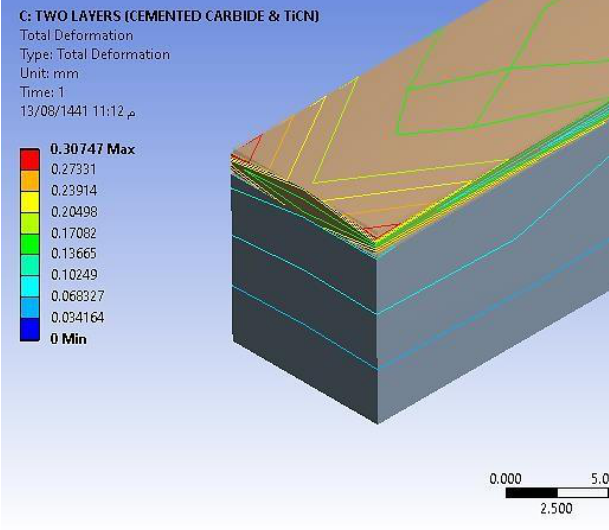
Fig. 21. Graph of total deformation normal force on the TiCN surface, 250 N load with thermal condition of 500 °C When a normal load of 250 N was applied at a thermal condition of temperature 500 °C on the whole elements it was observed that if the thickness is increased, and the total deformation decreases.